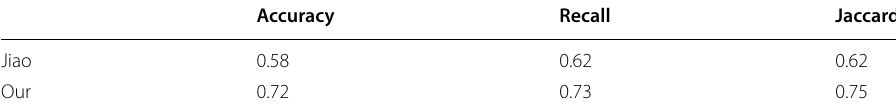
Table 3 Results of the multi-class classification Accuracy Recall Jaccard Jiao 0.58 0.62 0.62